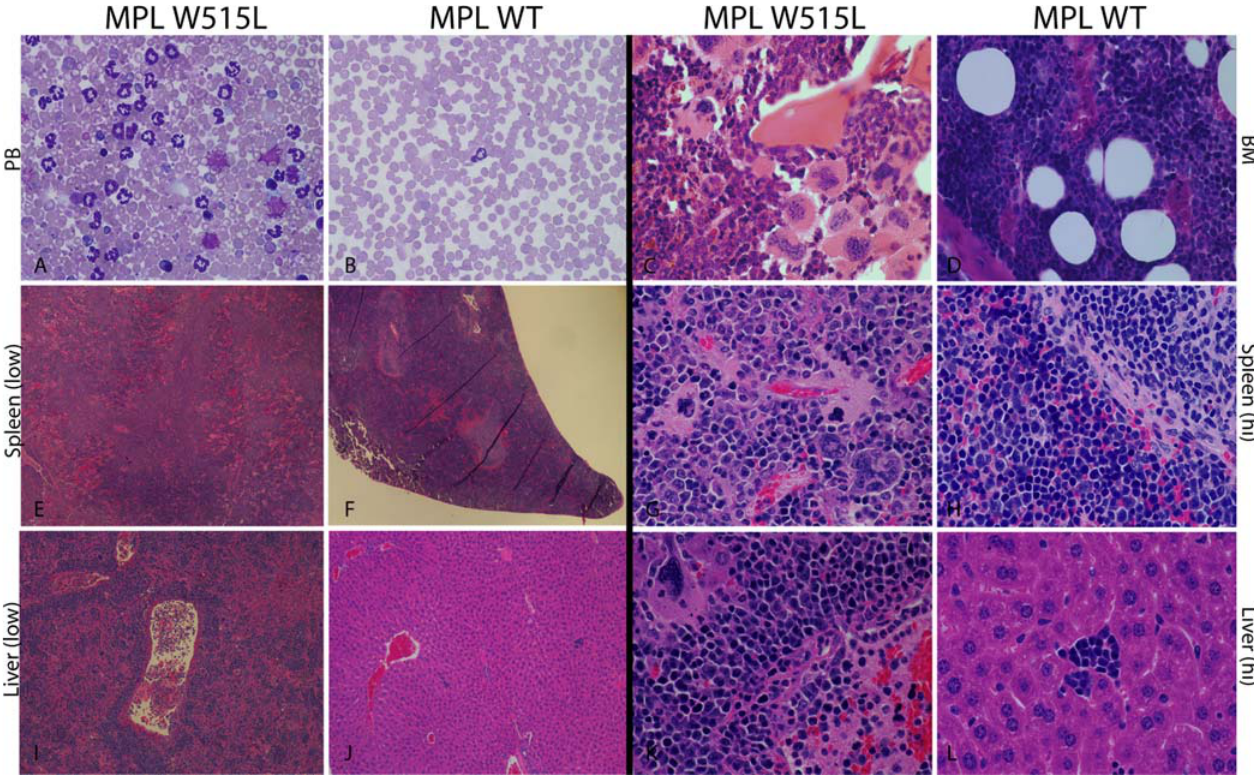
Figure 4. MPLW515L and MPLWT Bone Marrow Transplant Model Histopathology Histology of MPLW515L-transduced and MPLWT-transduced Balb/C mice showing images of peripheral blood (A and B) and histopathology in representative sections of bone marrow (C and D), spleen (E–H), and liver (I–L). Peripheral blood smear (B) (600 3 , Wright-Giemsa) of a representative MPLWT animal displays an unremarkable white blood cell and platelet count. In contrast, peripheral blood smear (A) (600 3 , Wright-Giemsa) of a representative MPLW515L mutant animal reveals marked thrombocytosis and leukocytosis comprising a predominant population of maturing myeloid cells as well as frequent nucleated erythroid forms. Bone marrow images from MPLWT animals display preserved marrow architecture with maturing trilineage hematopoiesis (D) (600 3 , hematoxylin and eosin [H&E]). Comparatively, bone marrow sections from MPLW515L mutant animals demonstrate marrow elements comprising a prominent population of maturing myeloid cells with increased numbers of megakaryocytes including atypical and dysplastic forms occurring in frequent clusters (C) (600 3 , H&E) and showing emperipolesis of neutrophils in megakaryocyte cytoplasm. Spleen sections from MPLW515L mice display complete effacement of normal splenic architecture (E) (40 3 , H&E) with a marked expansion of red pulp that is composed of an admixture of maturing myeloid and erythroid elements and numerous numbers of atypical megakaryocytes (G) (600 3 , H&E) compared with MPLWT spleens (F and H) (40 3 and 600 3 , H&E), which display a relative preservation of normal spleen architecture and the presence of only maturing erythroid forms in the red pulp. Liver images from MPLW515L mice illustrate evidence of extensive extramedullary hematopoiesis in a perivascular and sinusoidal distribution (I) (100 3 , H&E) composed predominantly of a population of maturing erythroid elements with frequent large atypical megakaryocytes and occasional admixed myeloid forms (K) (600 3 , H&E). In comparison, only small, focal areas of nucleated erythroid cells were observed in livers from MPLWT animals (J and L) (100 3 and 600 3 , H&E). DOI: